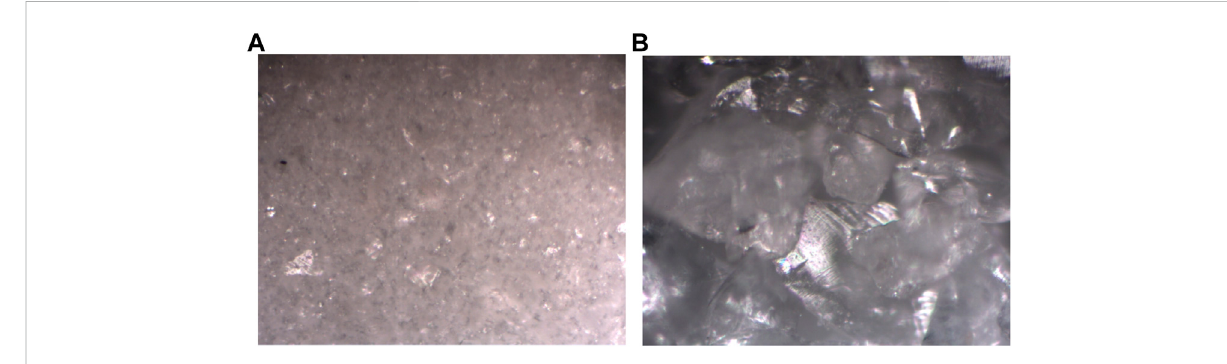
FIGURE 3 Image of soil and sand sample observed under the microscope. (A) kaolin (0 – 50 μ m), (B) quartz sand (150 – 230 μ m).